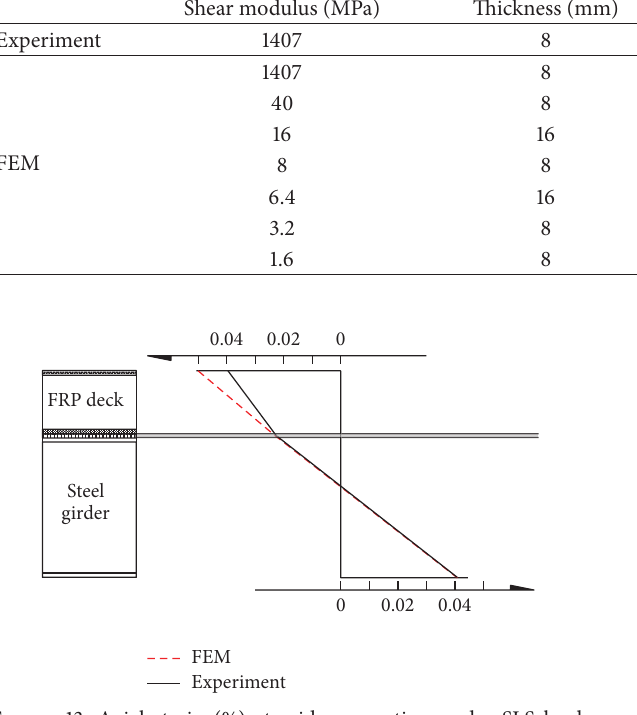
Figure 13: Axial strain (%) at midspan section under SLS loads (90kN/jack).